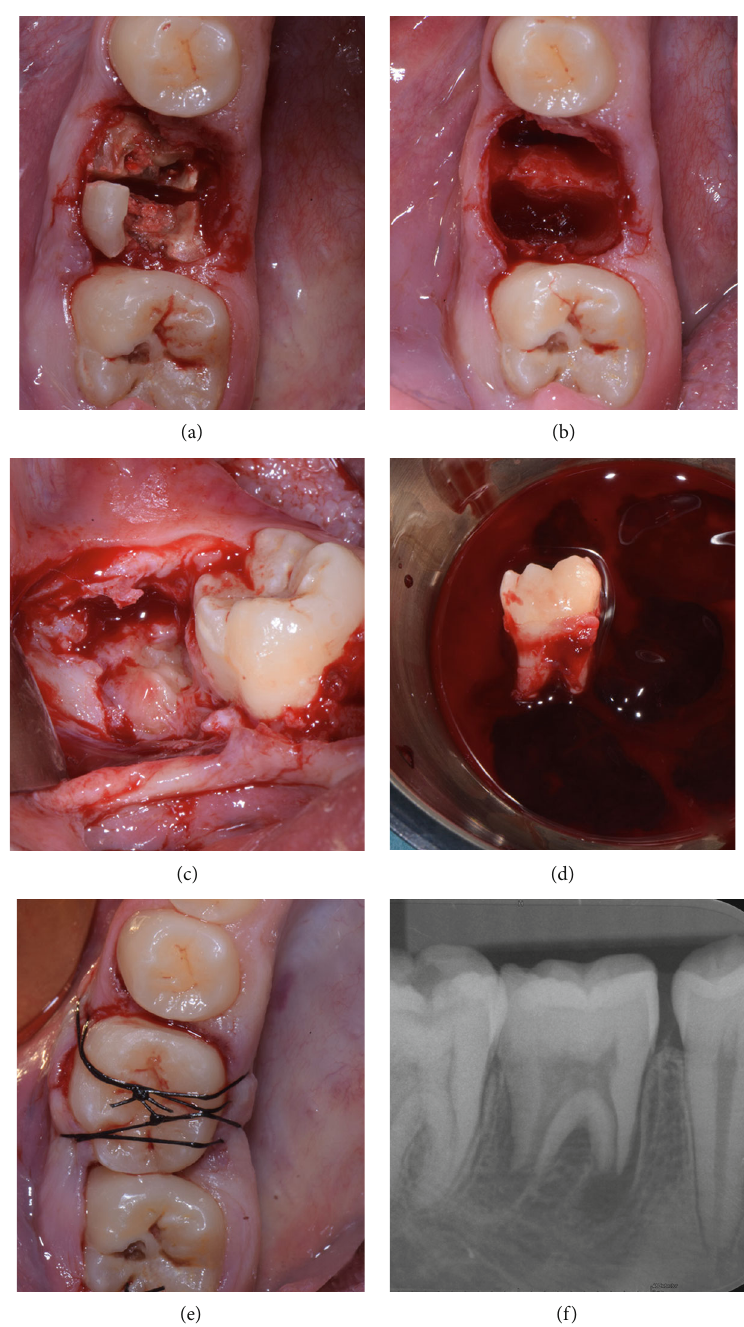
Figure 3: Tooth 46: (a) root ’ s separation; (b) alveolar fresh extraction socket; (c) impacted right third molar; (d) third molar donor tooth extracted and stored in the L-PRF exudate; (e) transplanted tooth in position 46 and cross-sutures for stabilization; (f) periapical radiograph immediately after